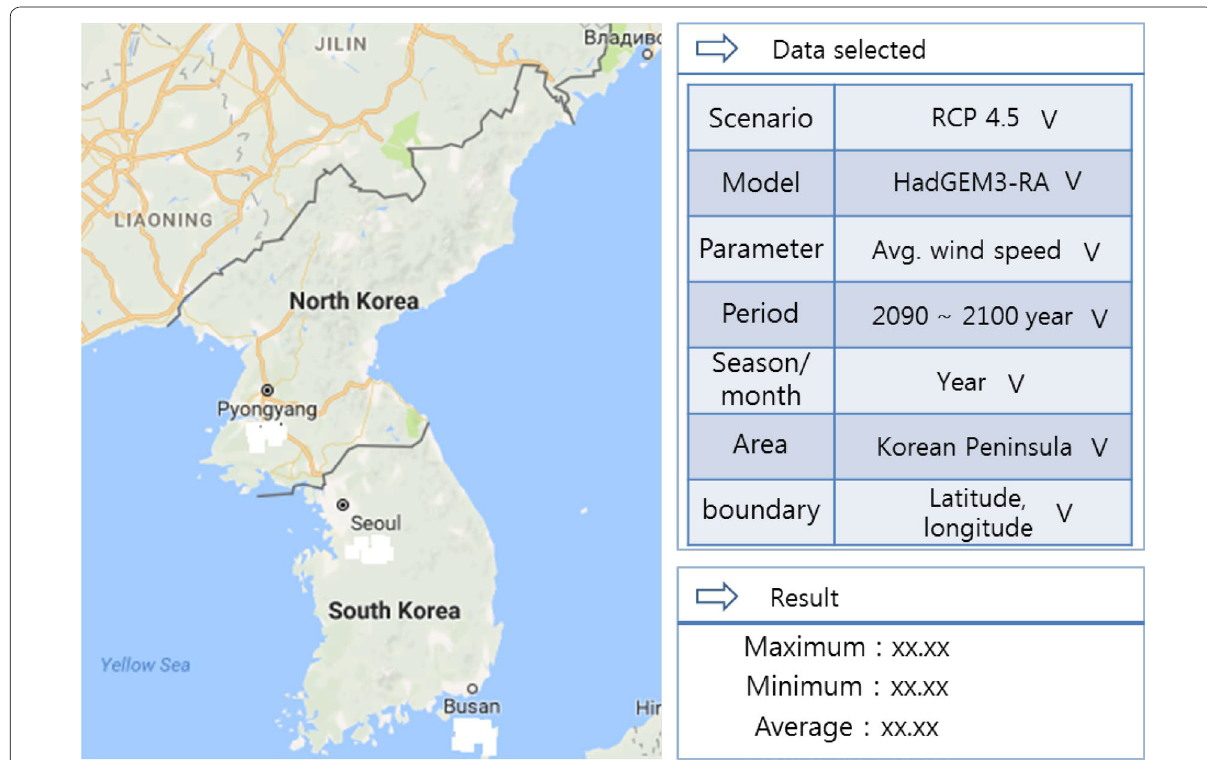
Fig. 13 Application of RCP scenarios.